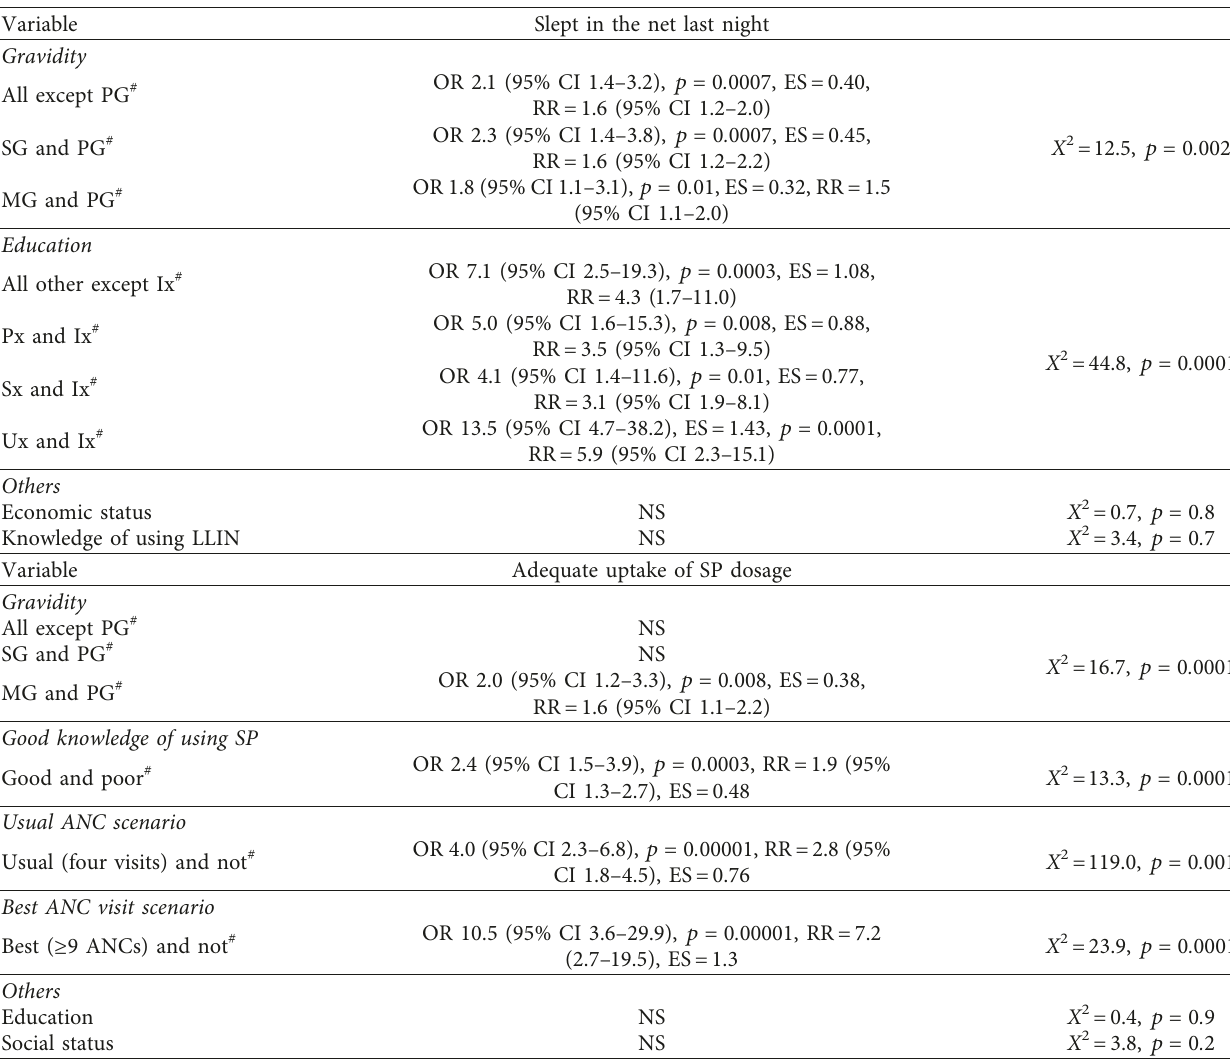
Table 1: Association between characteristics and malaria prevention